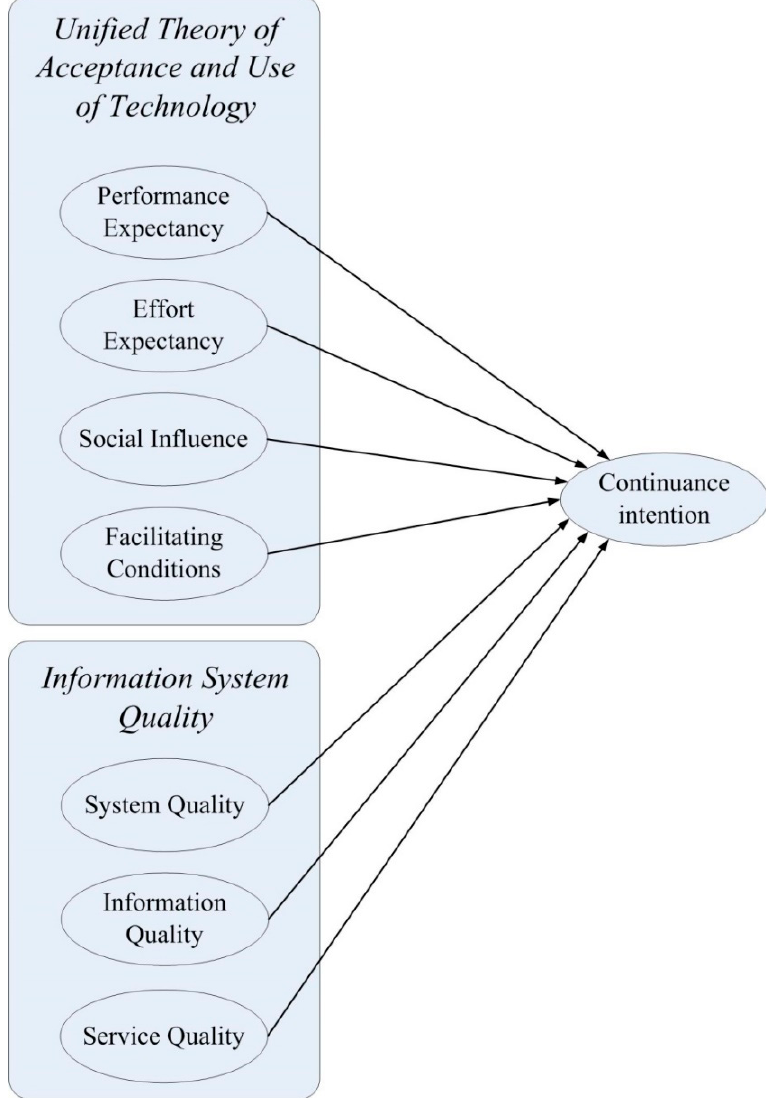
Figure 1. Research model.